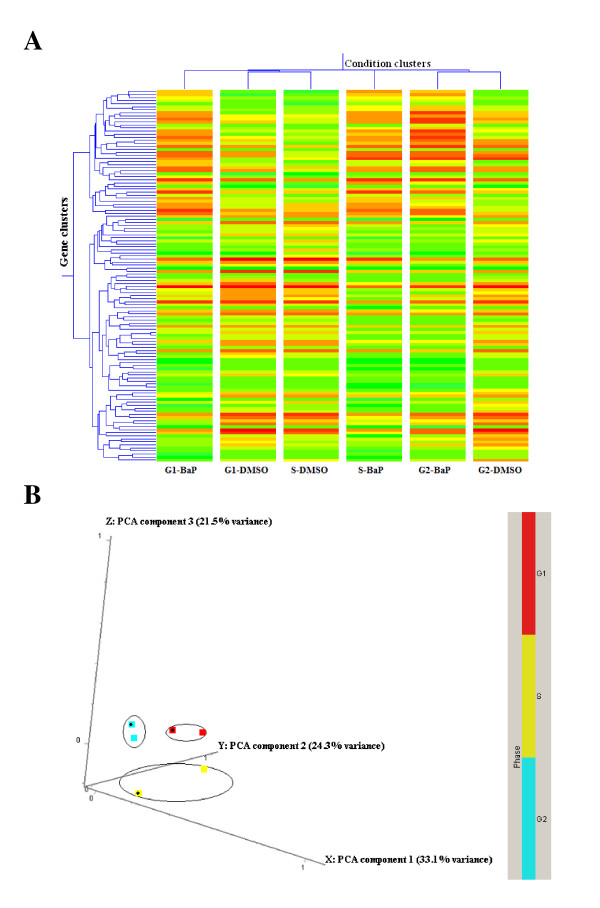
Cell cycle effects on microarray results. A- Hierarchical clustering of genes in different conditions; B- Principal component analysis (PCA). Both methods were performed in GeneSpring on a list of genes that had good confidence measurement and revealed a cell cycle response in gene expression profiles. Before BaP (2.5 μM) treatment for 12 h, MCF-7 cells were synchronised in different phases of the cell cycle. In hierarchical clustering (A), red colour denotes up-regulation and green denotes down-regulation. In PCA analysis (B), squares with black dots denote BaP-treated samples.